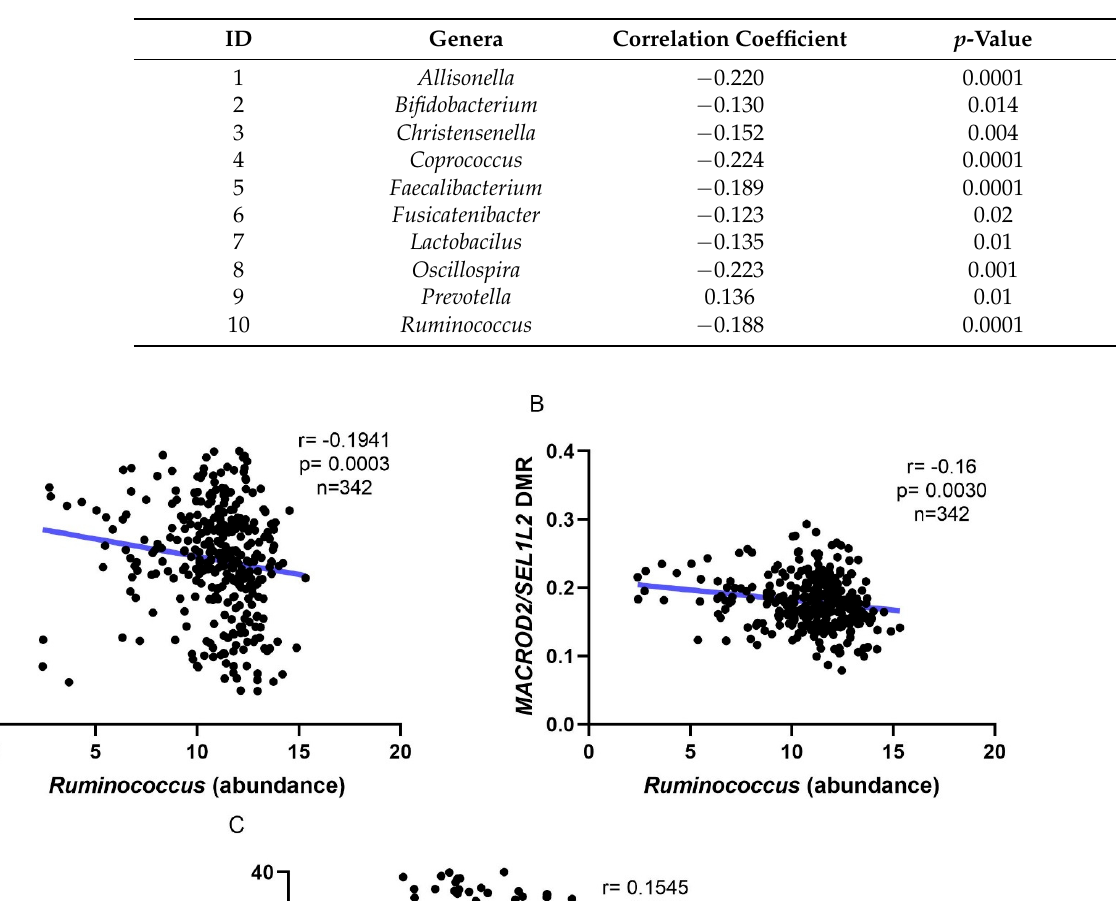
Table 2. Bacterial genera associated with BMI.